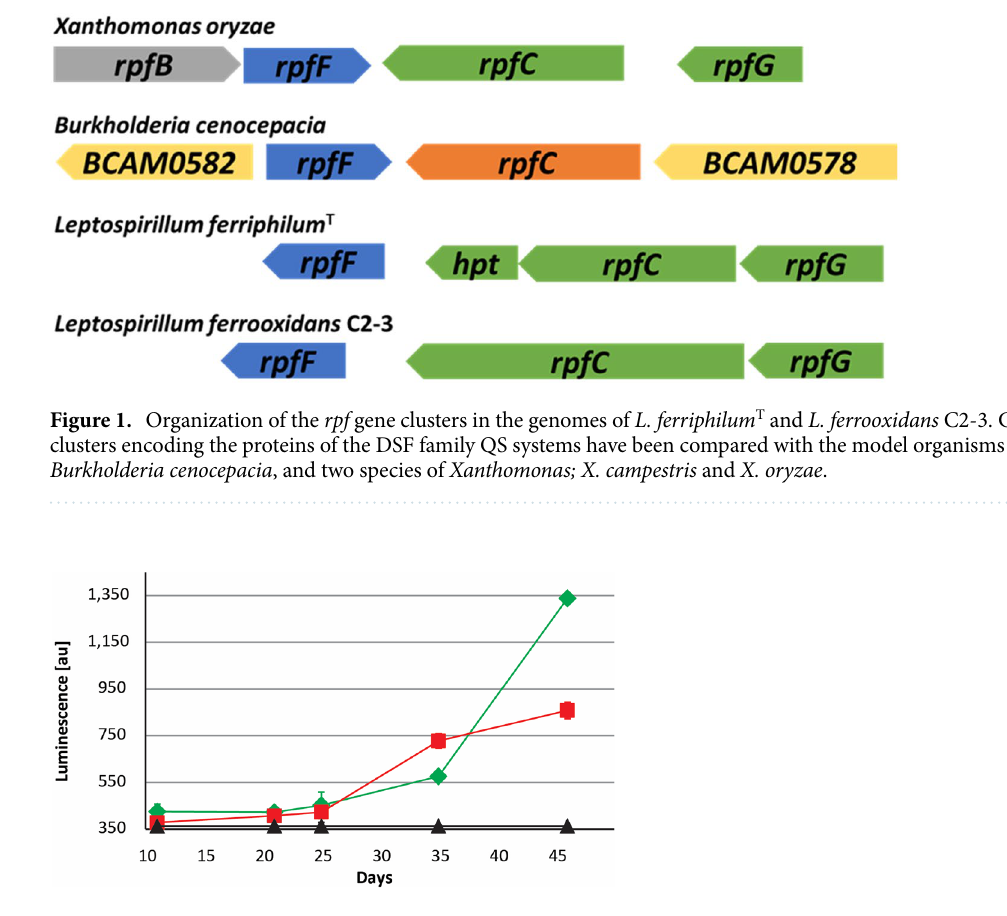
Figure 2. Bioassay for detection of BDSF and DSF in Leptospirillium spp. extracts cultured on pyrite. The black line and triangles indicate luminescence levels observed in control samples. The green line and diamonds or red line and boxes indicate luminescence levels in assays with extracts from L. ferriphilum T or L. ferrooxidans T , respectively. Data are averages ± SD of luminescence reads from triplicate experiments ( n =